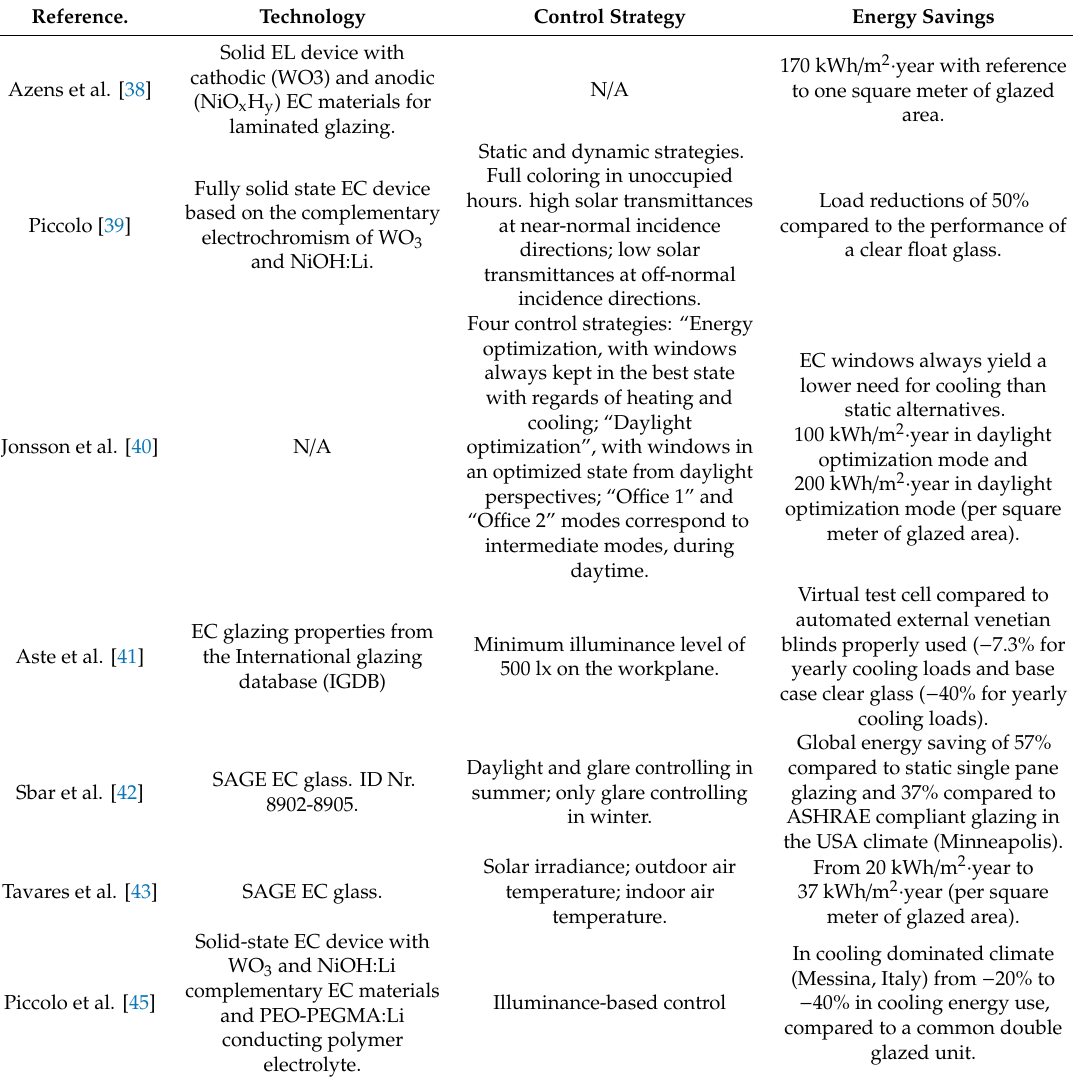
Table 1. Summary of the main technologies and relevant figures of merit discussed in Section 3.